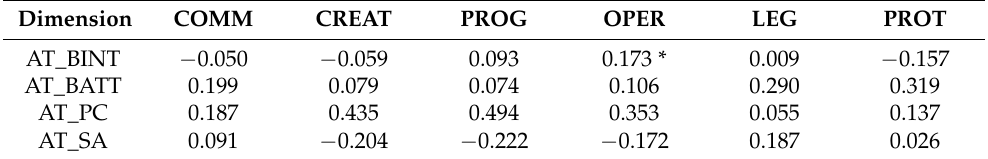
Table 2. Regression coefficients in the SEM model predicting digital knowledge and skills dimensions based on the attitudes dimensions of the digital competence for learning. The value marked with * is considered statistically significant. (AT_BINT—behavioural intention, AT_BATT—behavioural attitudes, AT_PC—perceived control, AT_SA—social aspects, COMM—communicating in the digital world, CREAT—creating digital materials, PROG—programming digital content, OPER—performing operations with digital tools, LEG—legal behaviour in the digital world, PROT—protecting oneself and others in the digital